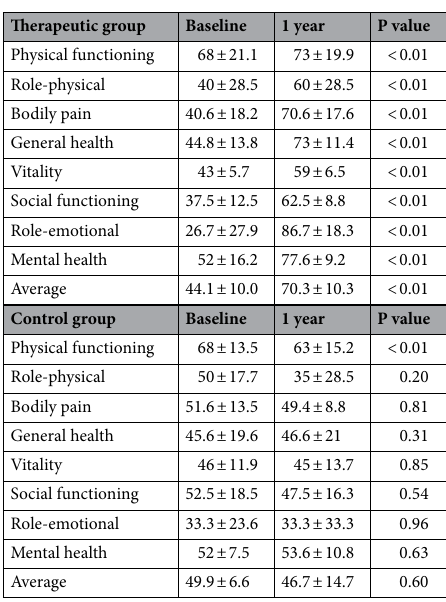
Table 3. Effect of psychotherapy on patient’s quality of life. Values are means ± SDs.